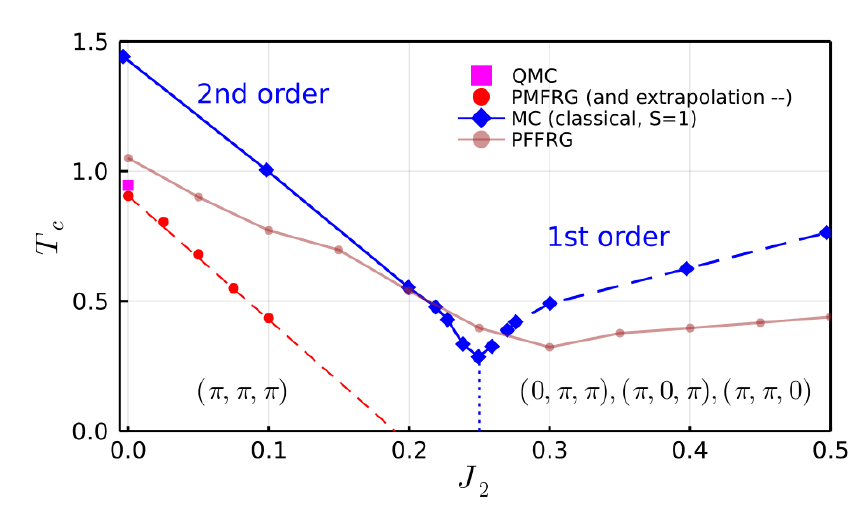
Figure 3: Finite temperature phase diagram of the simple cubic J - J Heisenberg 1 2 antiferromagnet. The data for the classical model with unit spin length is reproduced < 0.25 is second order, from Ref. [ 37 ] (blue), the transition to the Néel phase for J 2 > 0.25 is reached via a first order transition. The while the striped phase for J 2 PFFRG result reproduced from Ref. [ 27 ] is shown in brown. The one-loop PMFRG results (red dots) for ordering temperatures are only available for the second-order transition and at not too small temperatures; extrapolation to larger J (red dashed 2 (cid:39) 0.19 at T = line) yields J 2, c